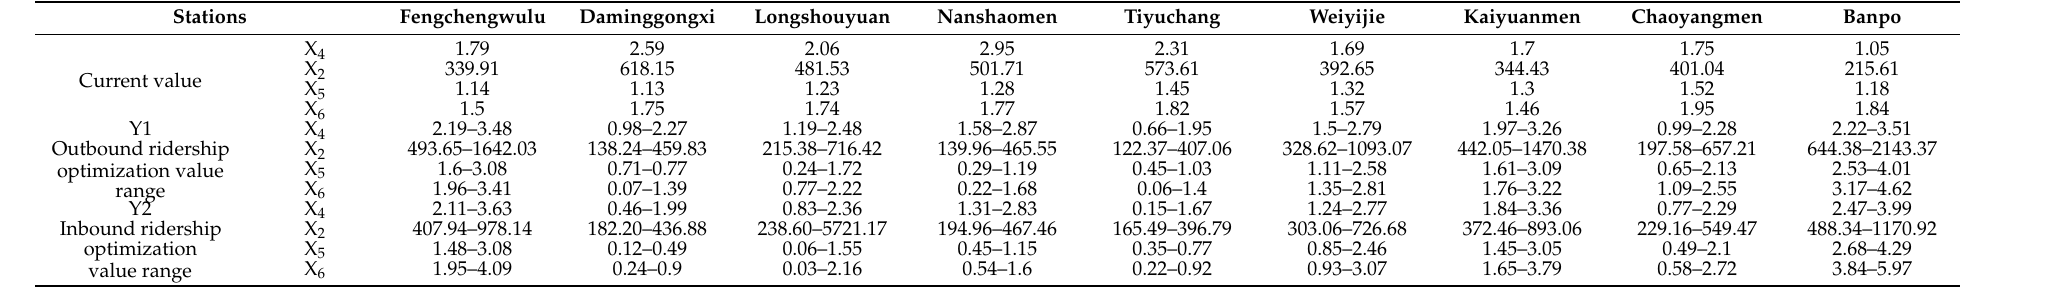
Table 3. Optimum value ranges of the average plot ratio, total building area, building mix diversity, and land use mix